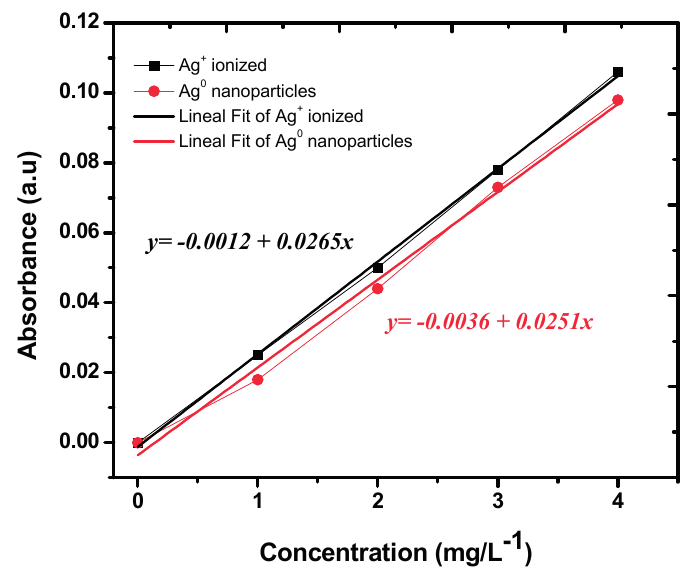
Figure 3. AAS calibration curves associated with the Ag ions and Ag nanoparticles. Experimental data and linear fit.